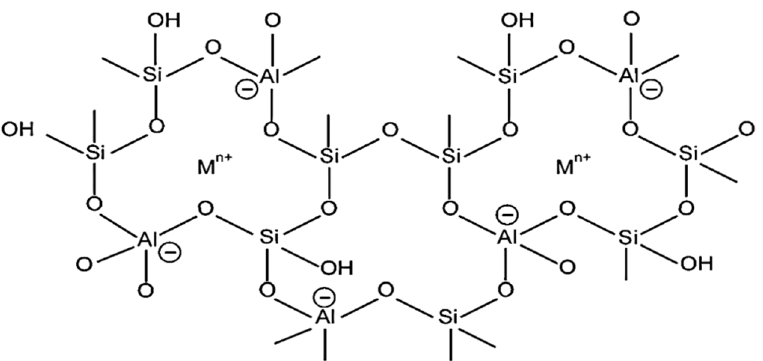
Figure 5. A two-dimensional illustration of the zeolite framework. Reprinted with permission Ref. [62]. Copyright 2006 Elsevier. from Ref. [62]]. Copyright 2006 Elsevier.